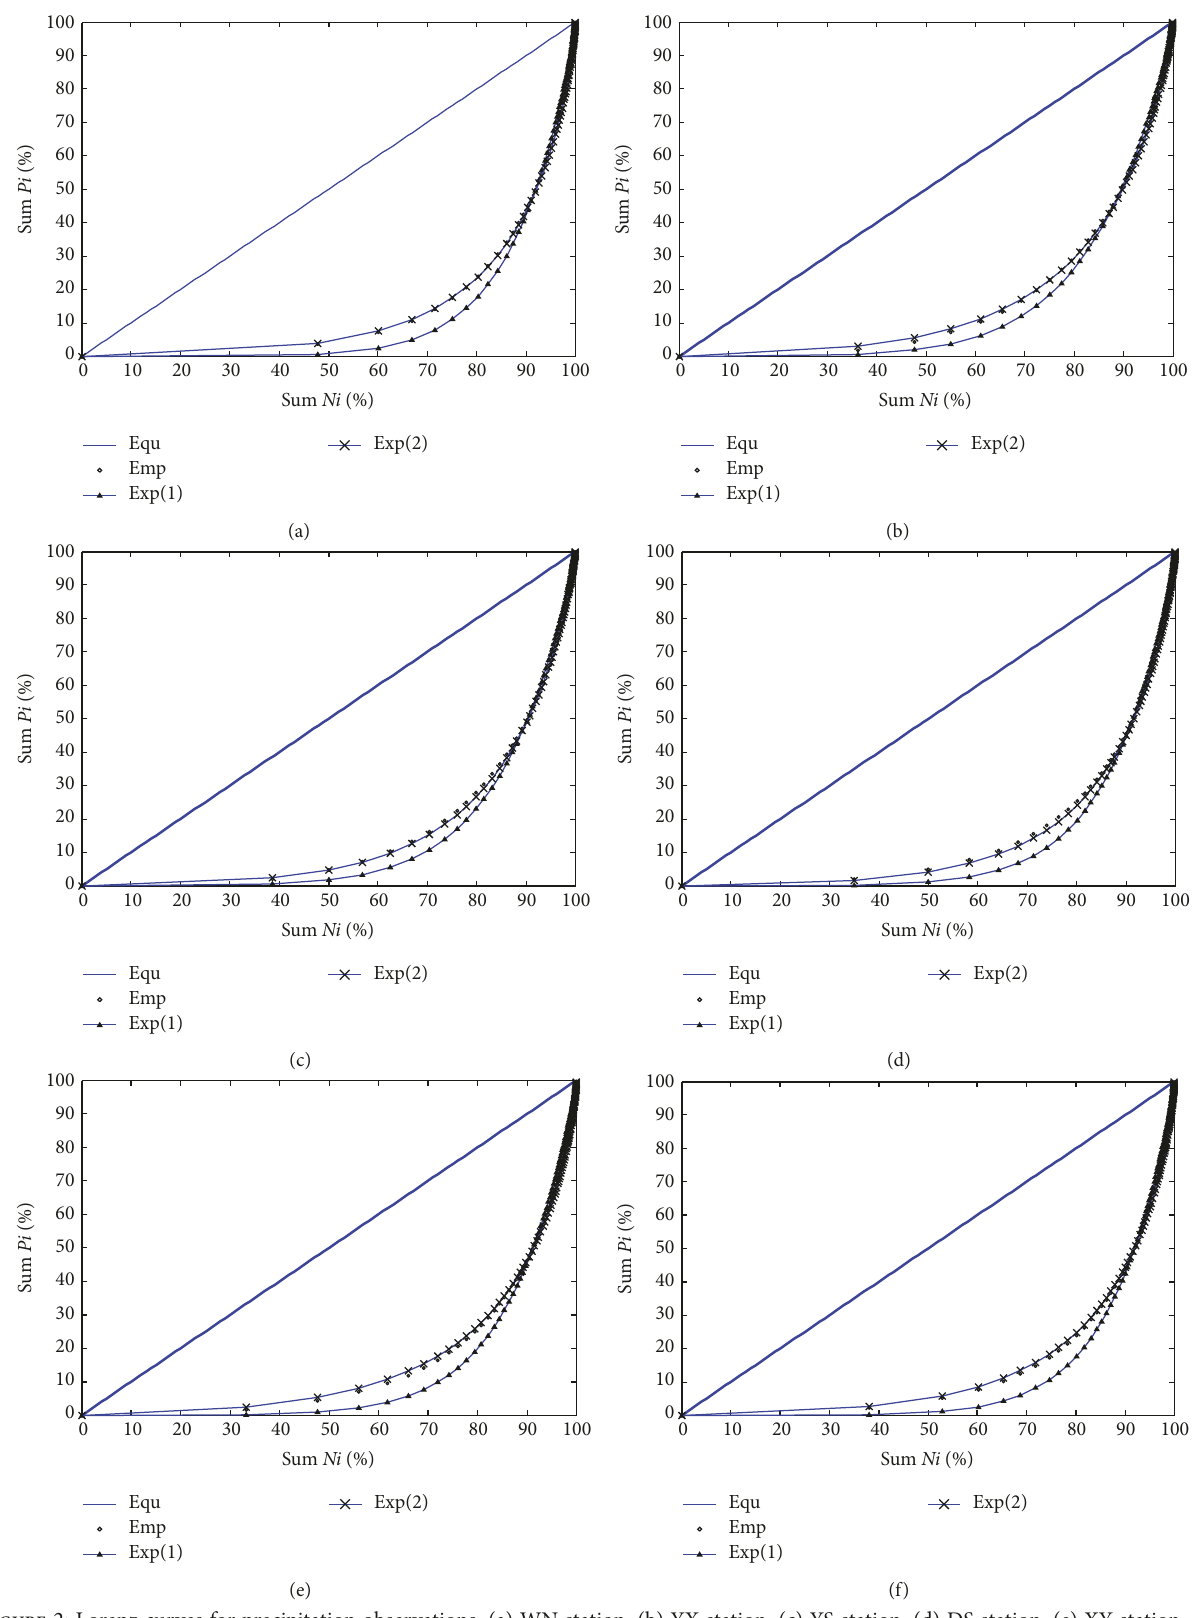
Figure 2: Lorenz curves for precipitation observations. (a) WN station, (b) YX station, (c) YS station, (d) DS station, (e) XY station, and (f) XR station. The straight line denotes the equidistribution line, circles denote empirical values (observed precipitation), the line with triangles denotes the exponential values calculated by (1), and the line with crosses denotes the exponential values calculated by (2). 𝑃𝑖 is the precipitation on day 𝑖 = 1,...,𝑛 . 𝑁𝑖 is the day (period from 1959 to